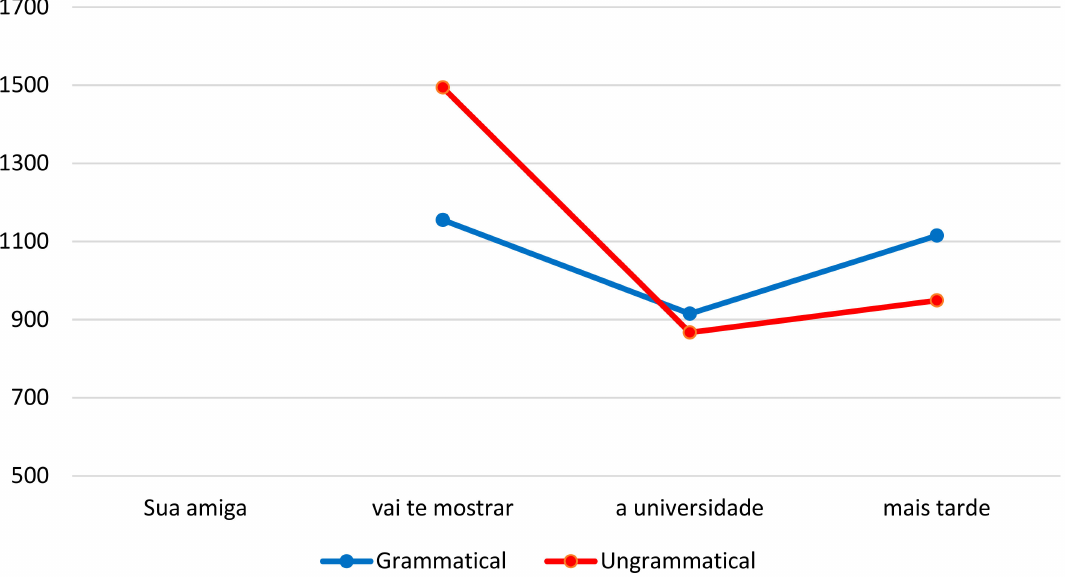
Figure 4. L1 BP speakers in the restructuring condition.